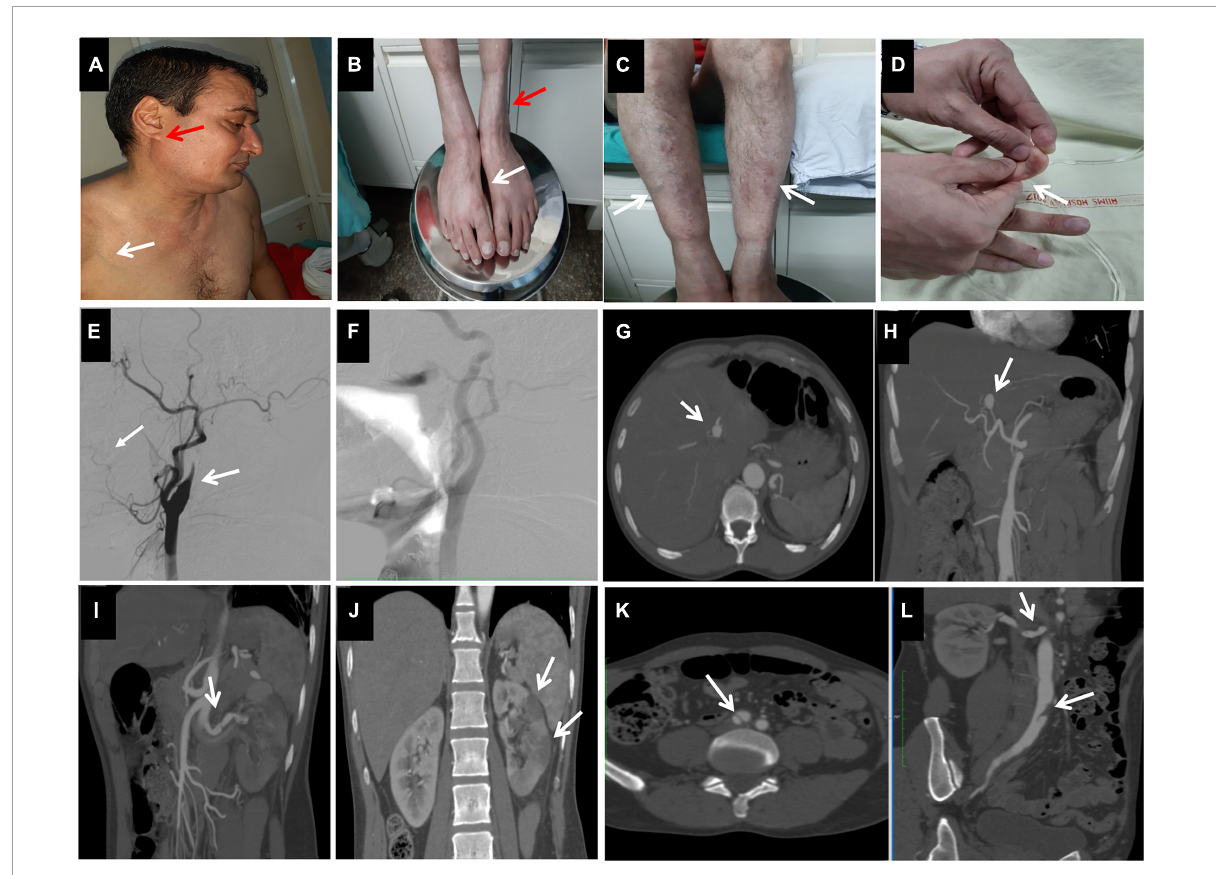
FIGURE1 Observed clinical features of the patient, (A): Thin Nose, lobe less ear (red arrow), thin skin with visible chest veins (white arrow), (B): Acrogeria (red arrow) with club foot (white arrow), (C): Easy bruising and thin skin, varicose veins, (D): Hypermobility of small joints (shown in distal phalange of index finger). Digital subtraction angiography images of bilateral common carotid arteries showing dissection of left internal carotid artery (E,F) . Right internal carotid artery was normal. Axial (G) and coronal (H) maximum intensity projection (MIP) CT images showing aneurysmal dilatation of left hepatic artery. Coronal MIP images (I,J) of contrast enhanced CT show dissection involving left renal artery with multiple infarcts of renal parenchyma. Axial (K) and coronal (L) MIP CT images show dissection involving right renal artery and right common iliac